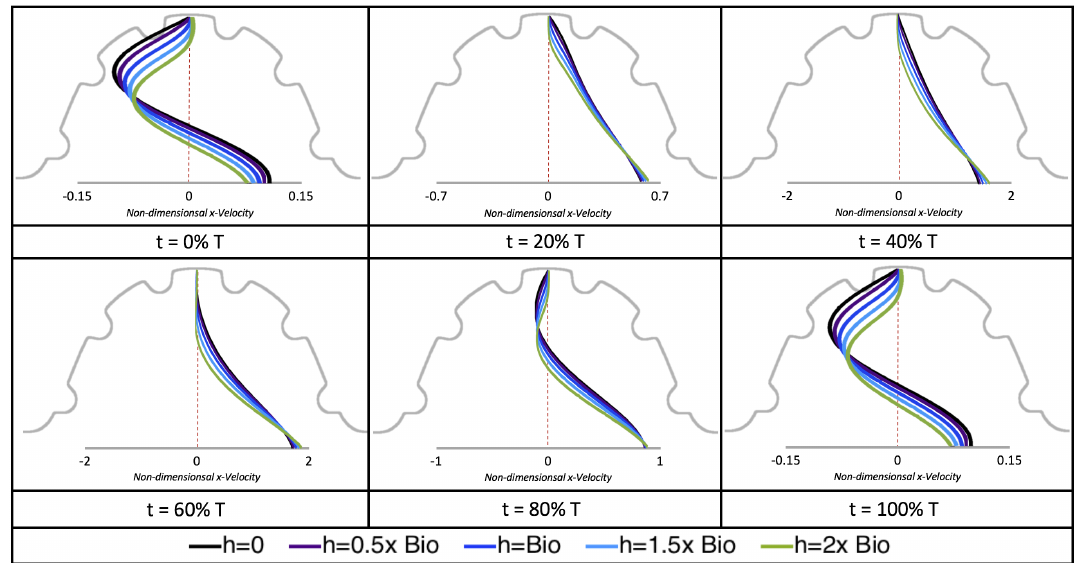
Figure 24. Snapshots during a pulsation cycle in the Re = 10 case of the horizontal velocity measured from the intracardial center to the intertrabecular region directly above for multiple trabeculae heights. Each sub-figure corresponds to a different time point described as a percentage of the pulsation cycle, T